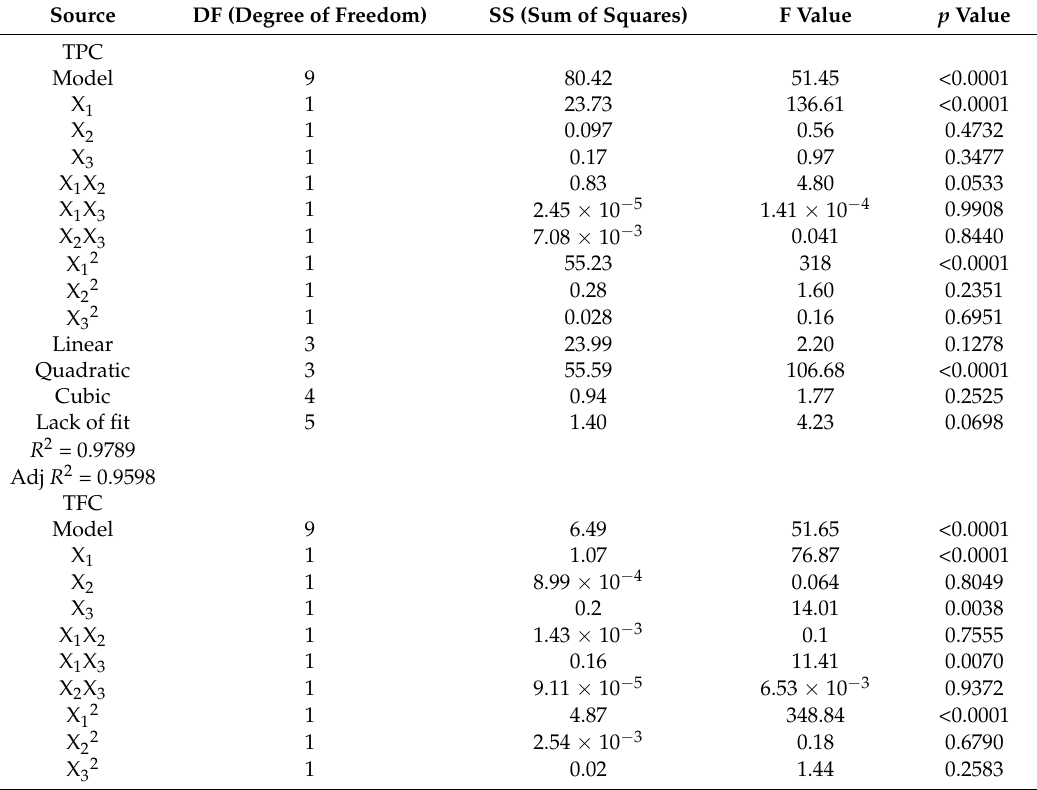
Table 2. ANOVA table for the effects of the ethanol concentration, extraction time and temperature on the TPC, TFC and antioxidant capacity of the Chenopodium formosanum seed